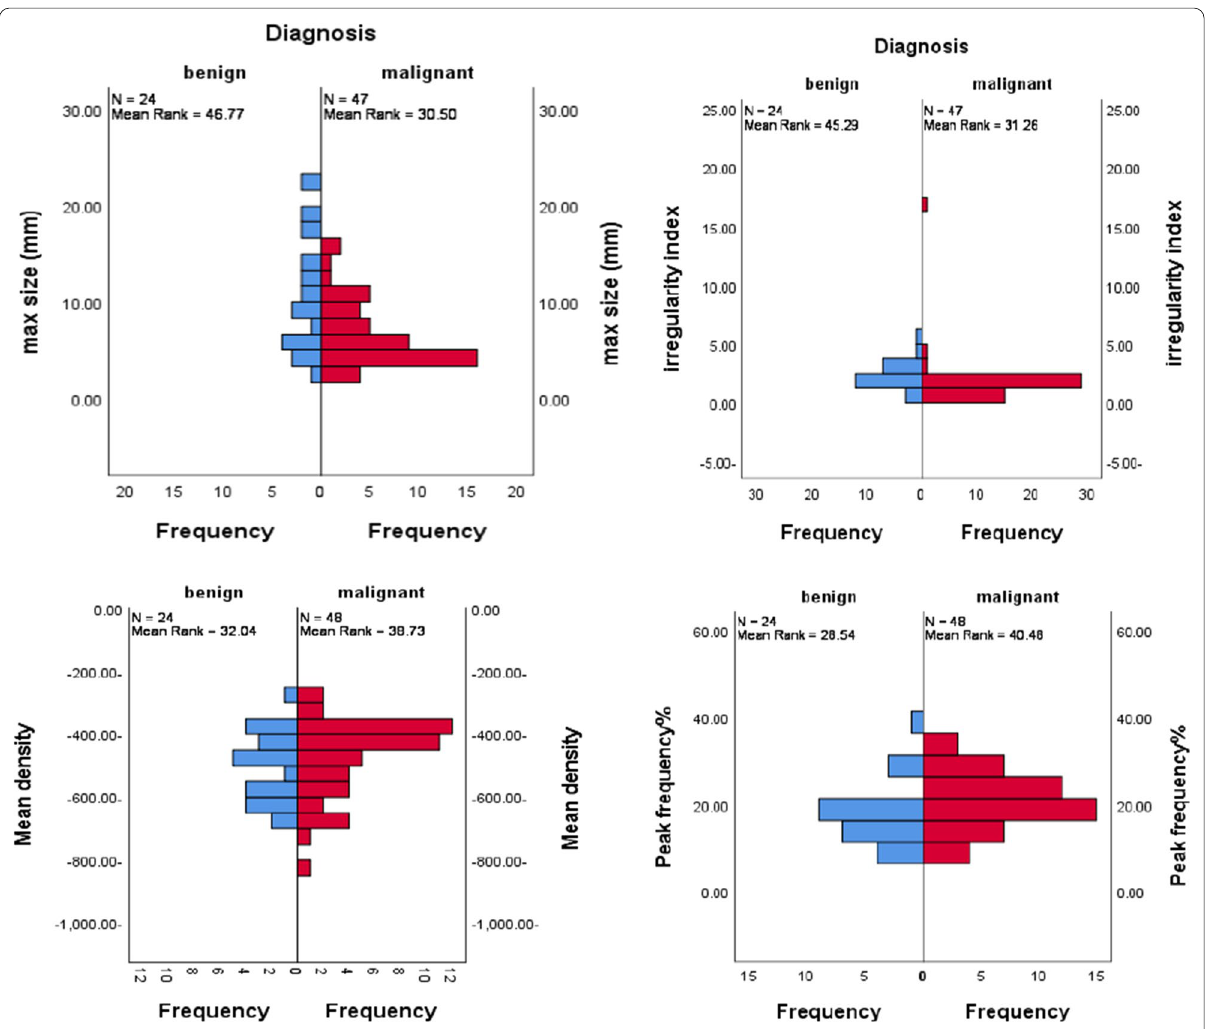
Fig. 2 Independent‑sample Mann–Whitney U‑test for splitting the neoplastic versus non‑neoplastic nodules according to nodule maximum long‑axis diameter, irregularity index, mean density, and peak